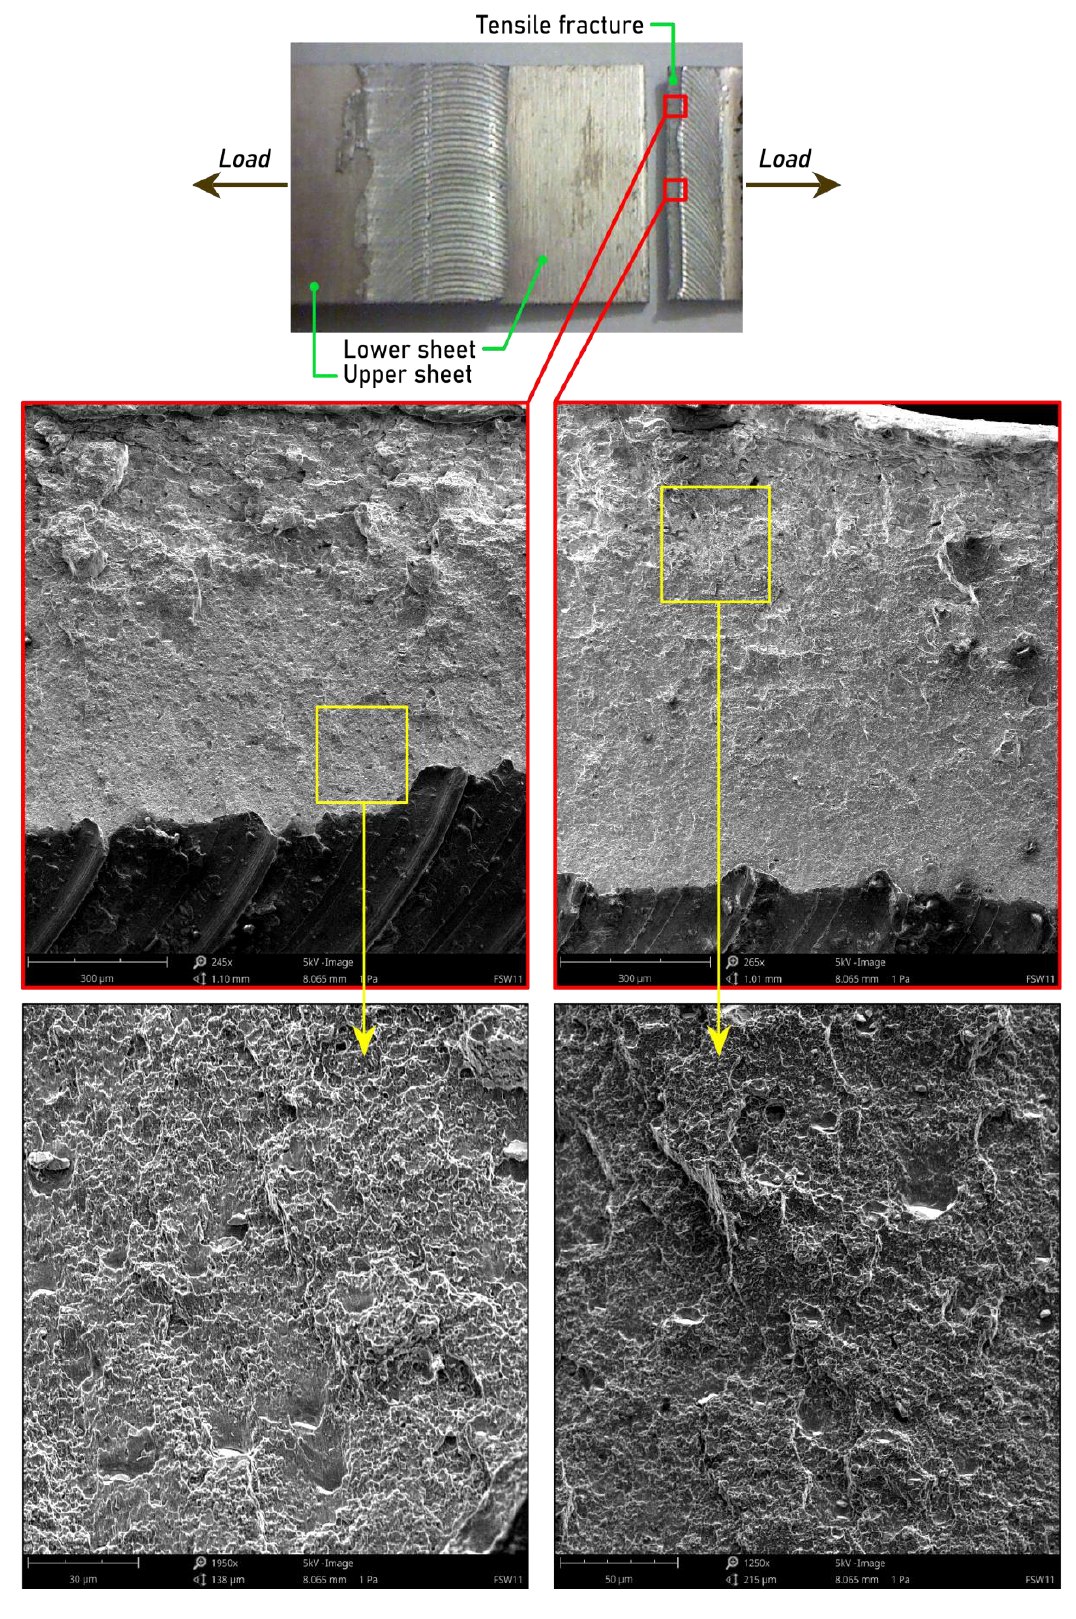
Figure 10. SEM images of a fracture surface of an FSW weld joint made using the following param- eters: pin length d = 1.5 mm, welding speed f = 200 mm/min, and tool rotational speed n = 1200 rpm.